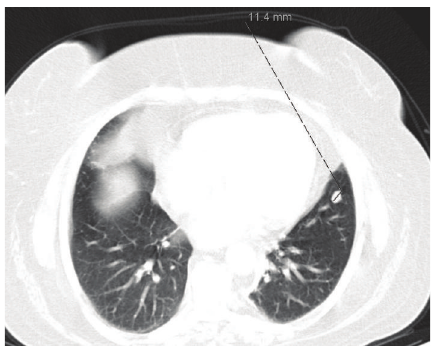
Figure 2: Chest CT